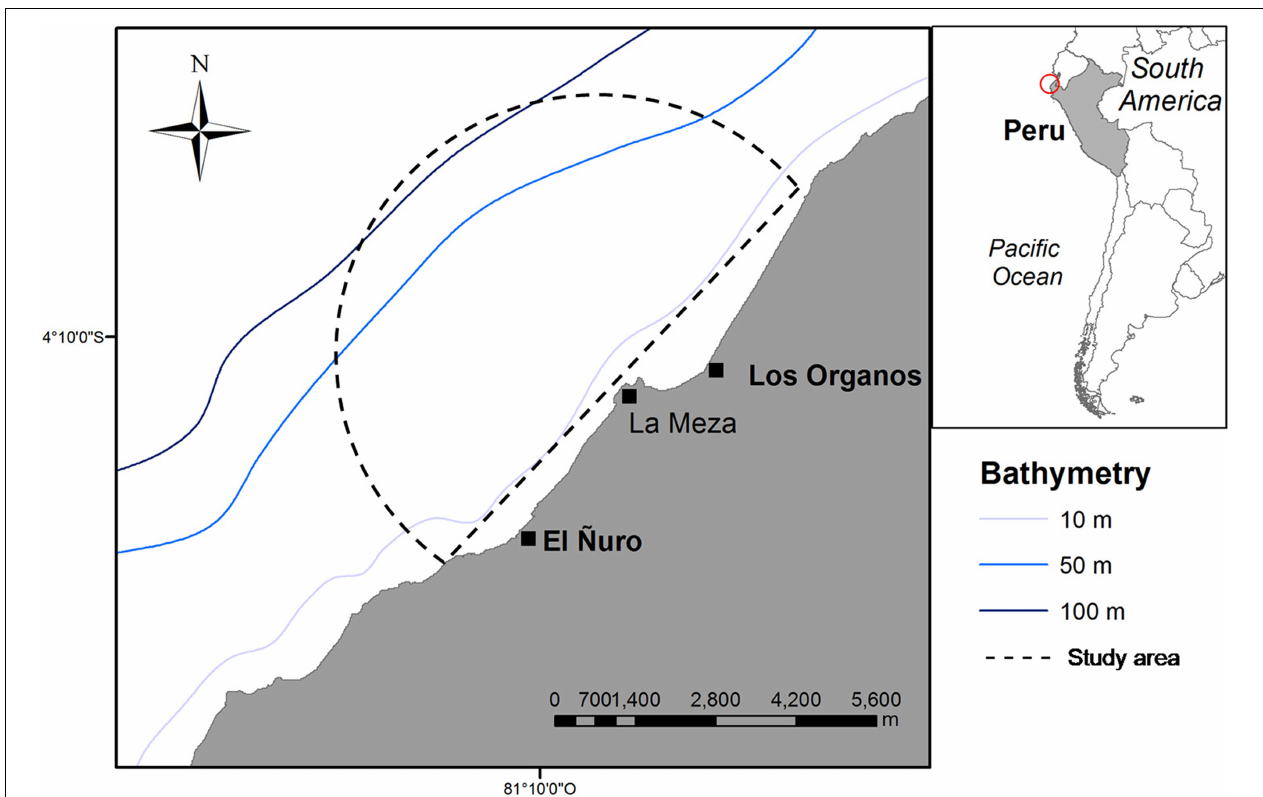
FIGURE 1 | Location of the studied area. Semi-circle represents the 7 km vision range from the observation point at “Cerro la